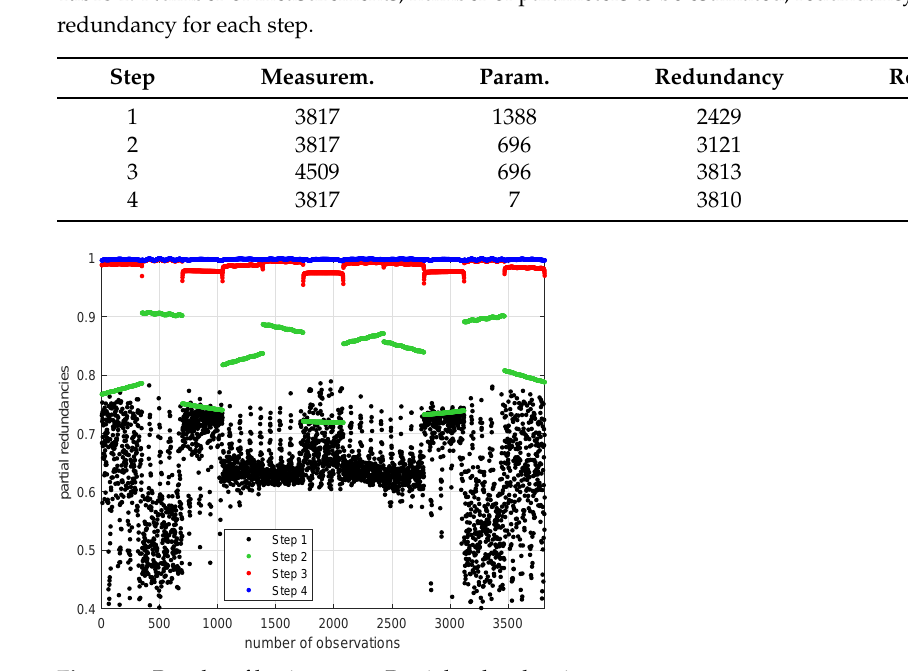
Figure 4. Results of basic set-up: Partial redundancies.